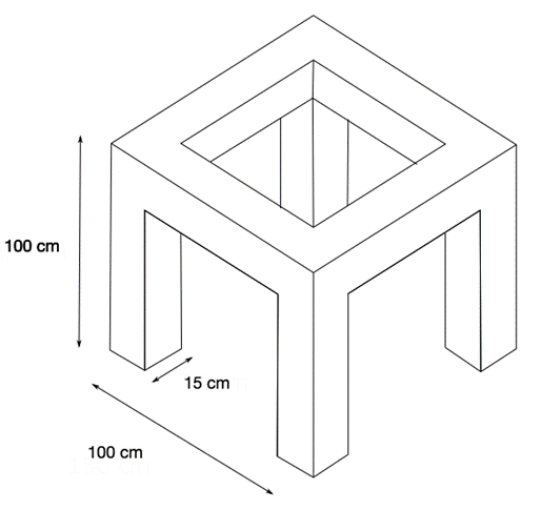
Figure 1. General dimensions of the framed